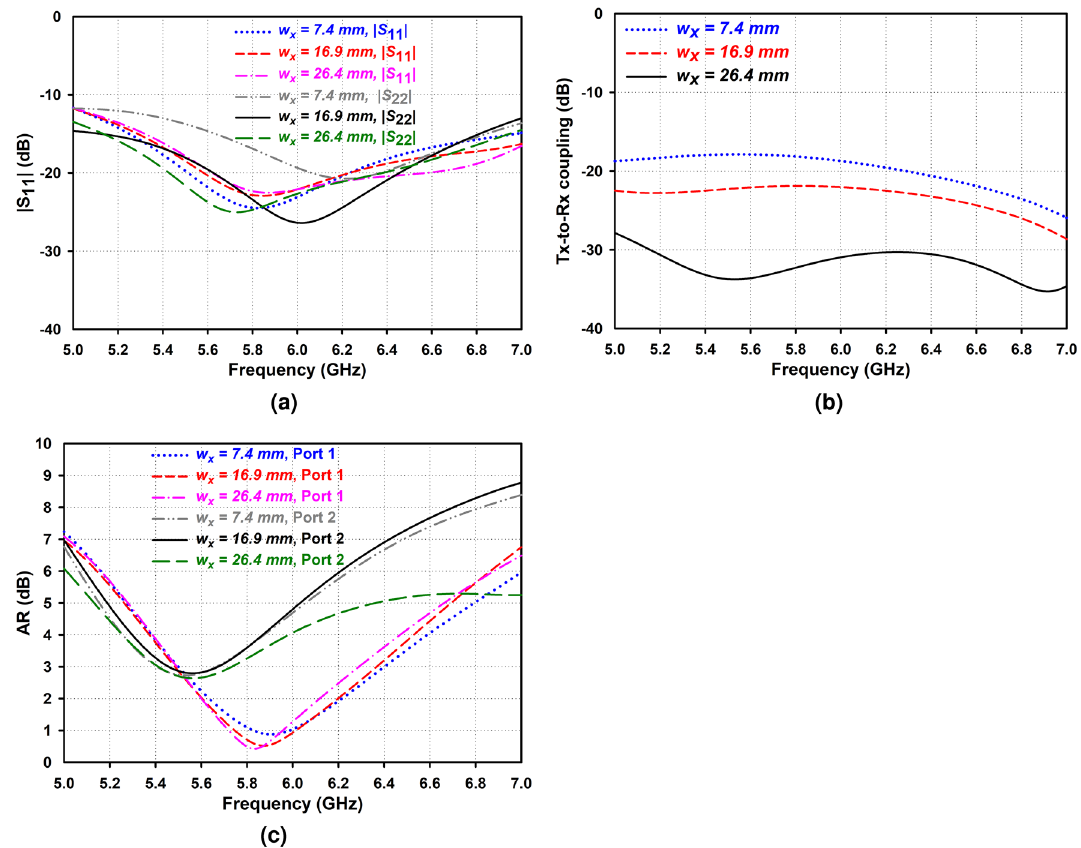
Figure 7. Effect of changing w x on ( a ) | S 11 | , ( b ) isolation, and ( c ) AR.